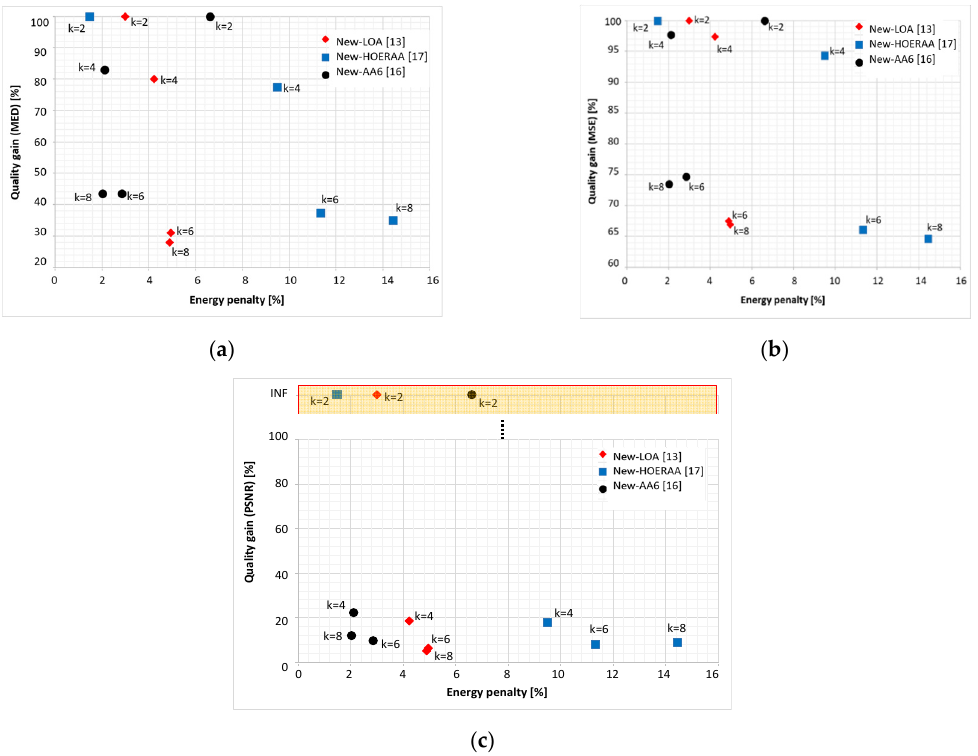
Figure 13. Quality gain versus the energy penalty in terms of: ( a ) MED; ( b ) MSE; ( c ) PSNR.